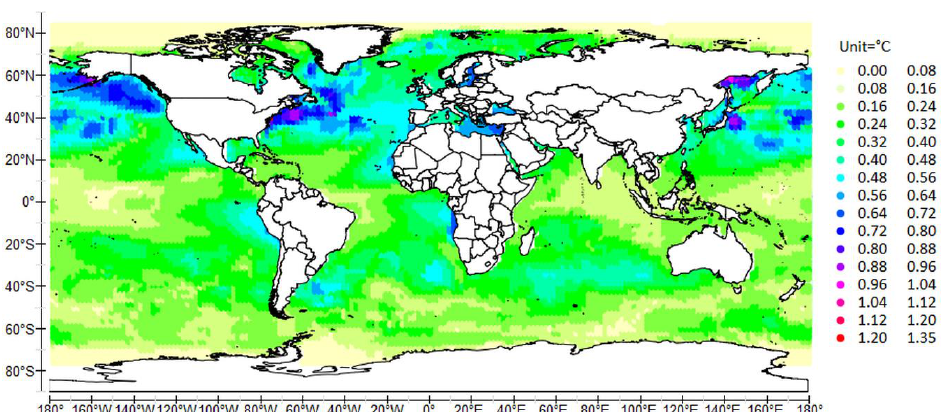
Figure 4. The wavelet power of SST scale-averaged over 52 – 74 years (64-year average period), time-averaged over 1870 – 2015. Resonances disclosed by SST anomalies are close to 40 ° N/S in latitude. They stretch from the Cape Hatteras in the North Atlantic, from the Japan in the North Pacific, from the mouth of the Rio Plata in the South Atlantic, from the southern tip of the continental shelf of Africa in the South Indian Ocean and from the New Zeeland in the South Pacific.